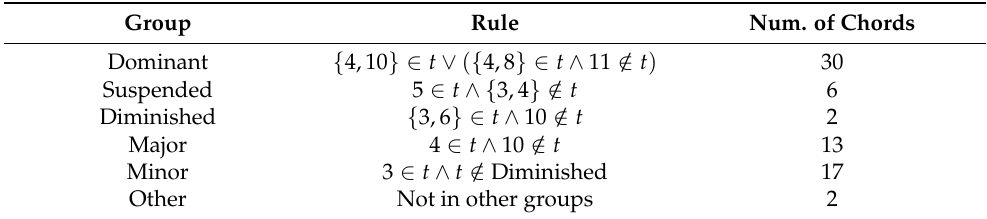
Table 1. Chord grouping method and number of chords per group. Chord types are represented by their pitch class set relative to the chord